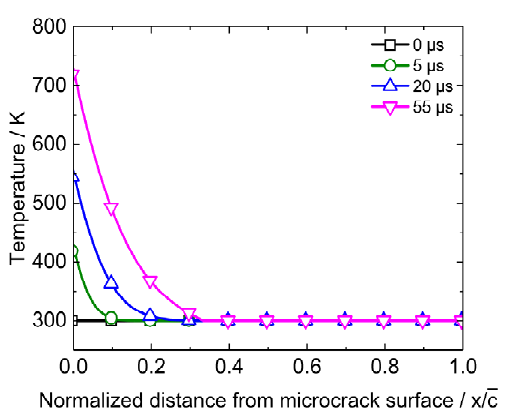
Figure 9. Distribution of temperature near the microcrack.